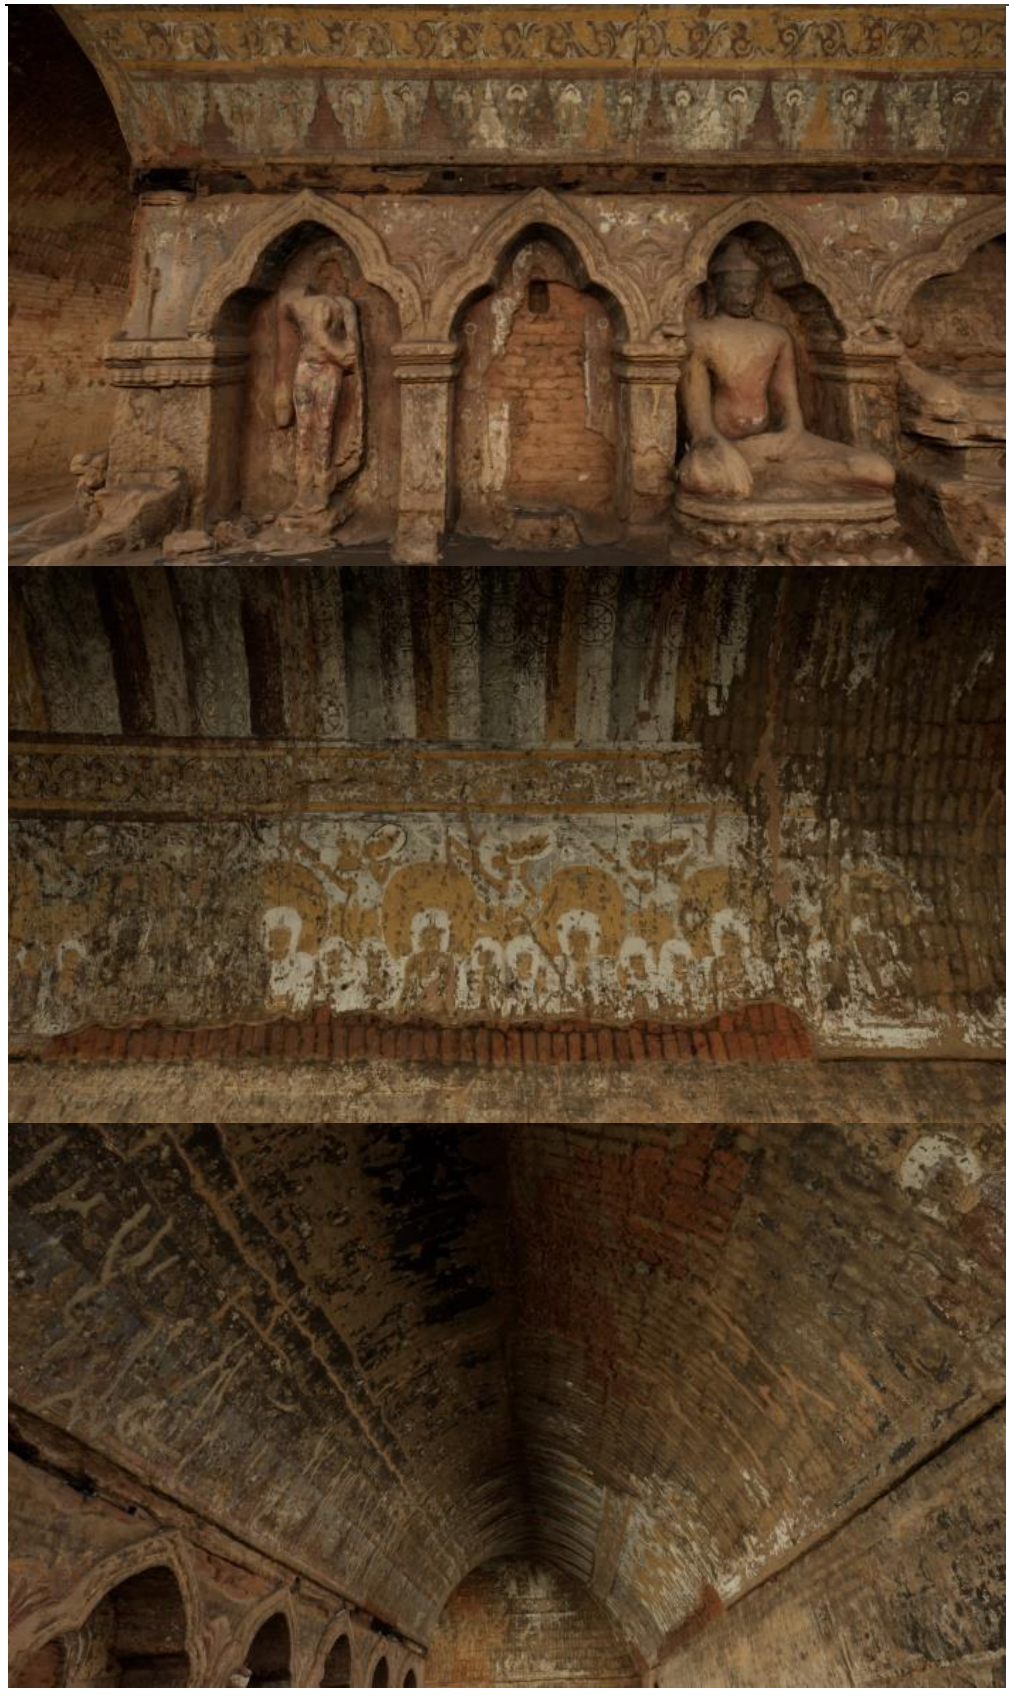
Figure 7. Screenshots from the Myin-pya-gu VR